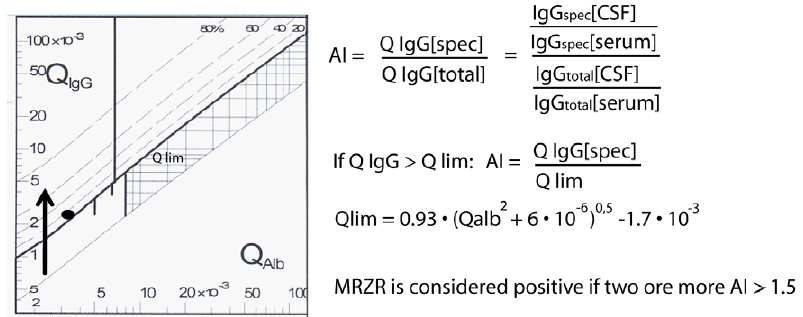
Figure 1. Reiber diagram and antibody index. Left side: Reiber diagram visualizing intrathecal IgG synthesis using a double-logarithmic scaling to present the IgG CSF to serum quotient (QIgG) in relation to the albumin CSF to serum quotient (Qalb), and showing the hyperbolic function Qlim that indicates the upper reference range of QIgG. In the upper right corner of the diagram, the relative extent of intrathecal IgG synthesis is indicated. Right side: Formula for antibody index (AI) and